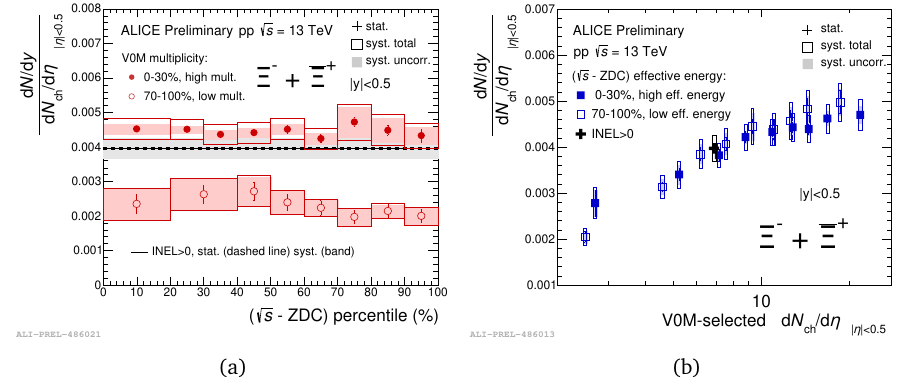
Figure 5: Ratio of Ξ yields to the charged-particle multiplicity extracted using V0- ZDC combined selections. (a) Events are selected using ZDC event classes, fixing the multiplicity through the V0 estimator. (b) Events are selected using V0 event classes, fixing the effective energy through the ZDC